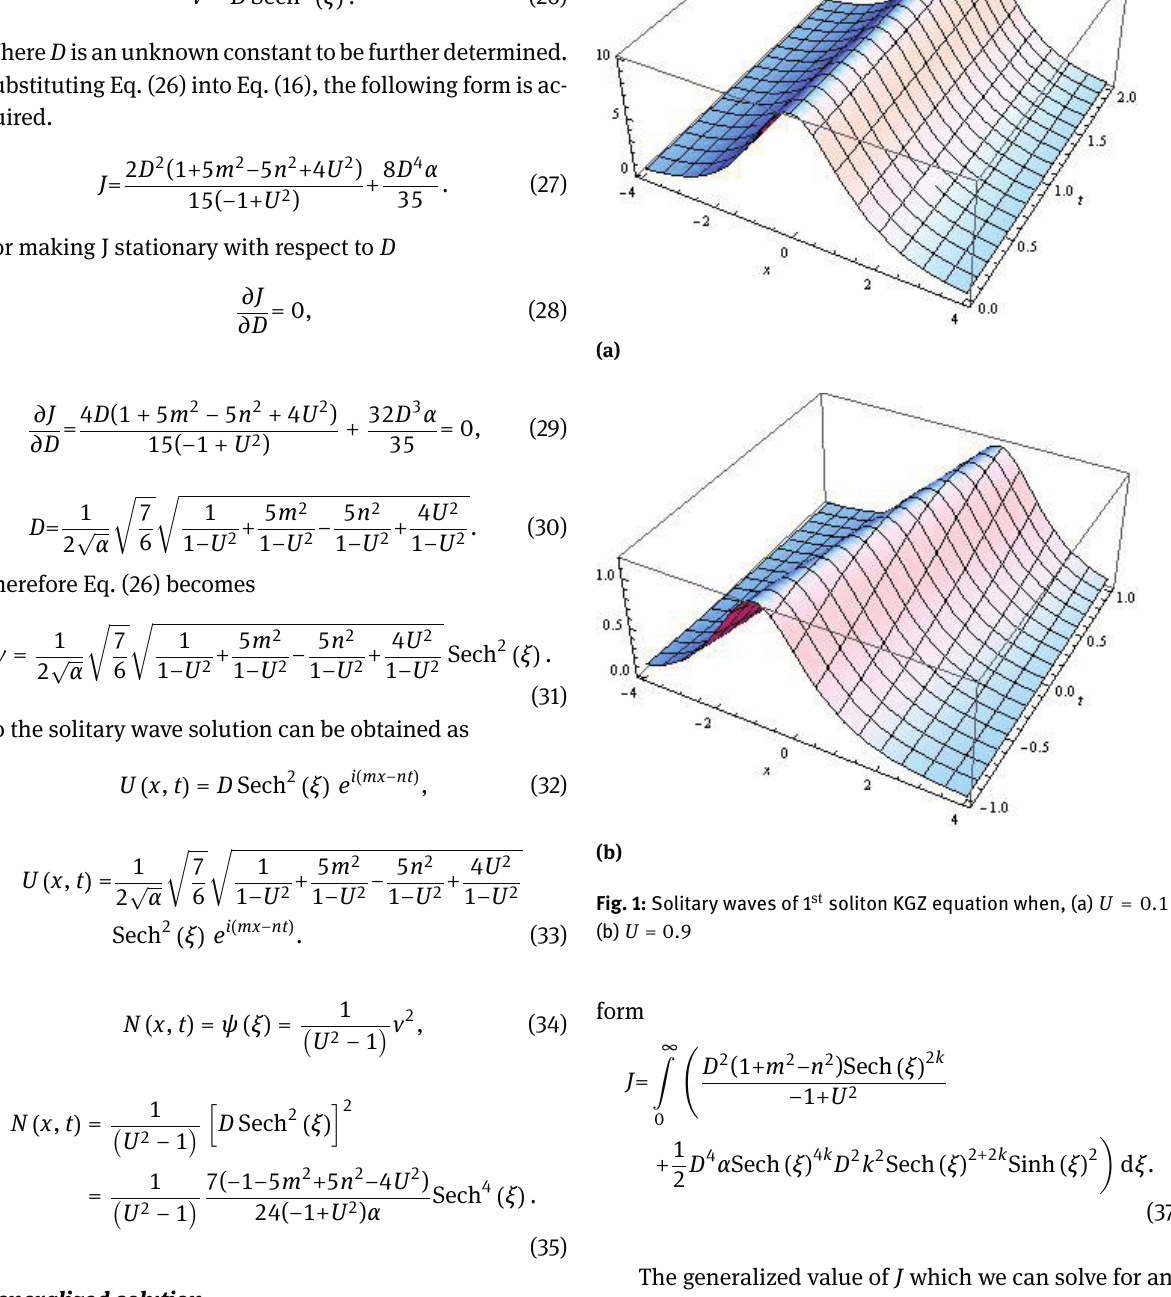
Fig. 1: Solitary waves of 1 st soliton KGZ equation when, (a) U = 0.1 (b) U =